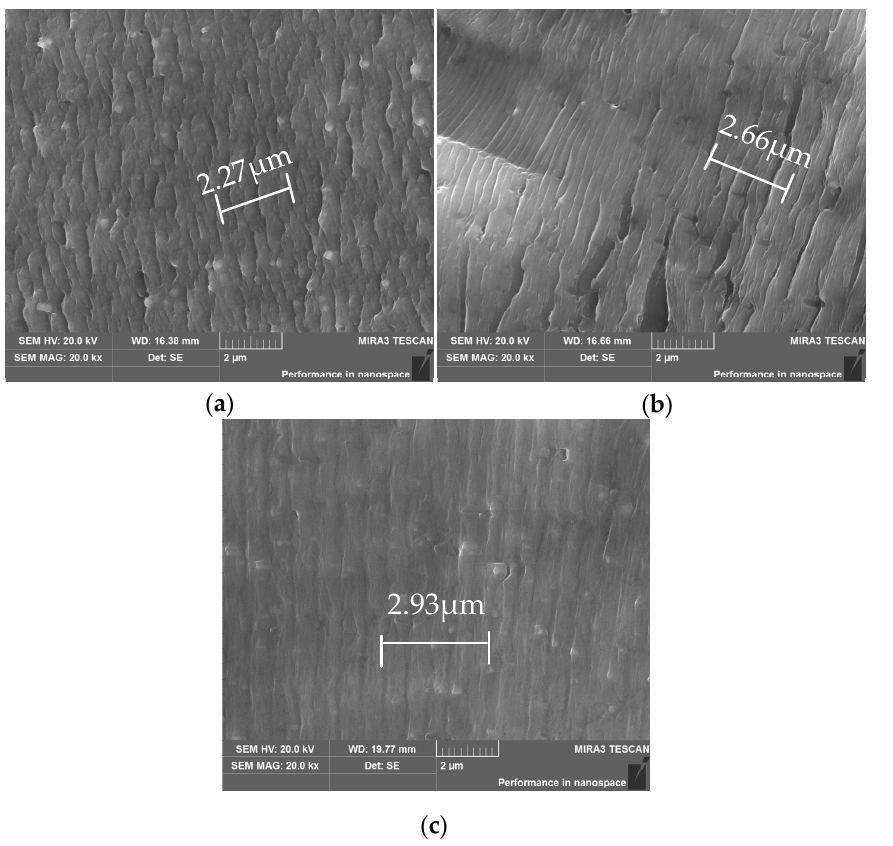
Figure 8. SEM images of fatigue striations under different curvature radii ρ : ( a ) ρ = 1000 mm; ( b ) ρ = 1500 mm; ( c ) ρ = 1800 mm.